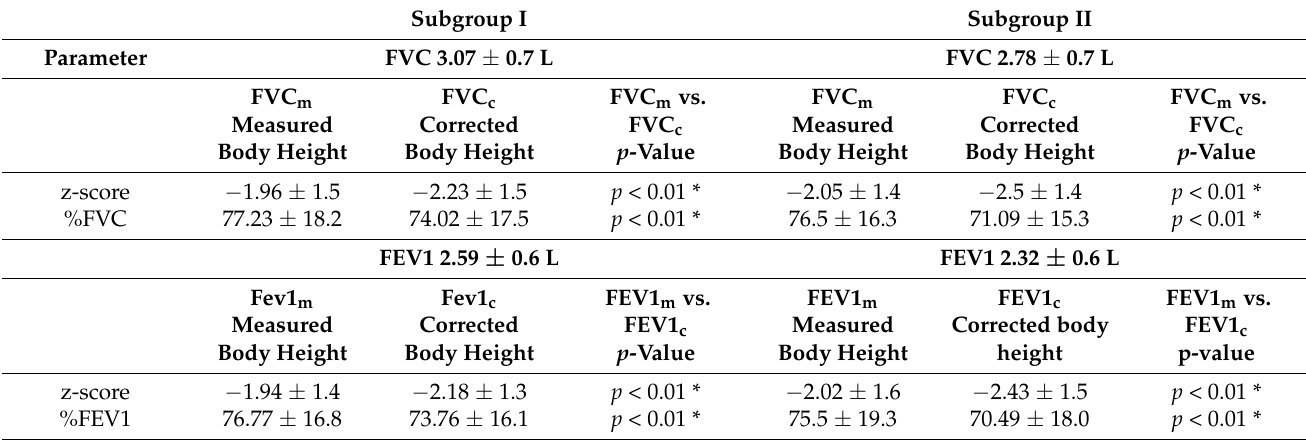
Table A6. Comparison of the pulmonary parameters calculated for the measured versus the corrected body height in subgroup I, N = 30 and subgroup II, N = 17 in Lenke 3 type